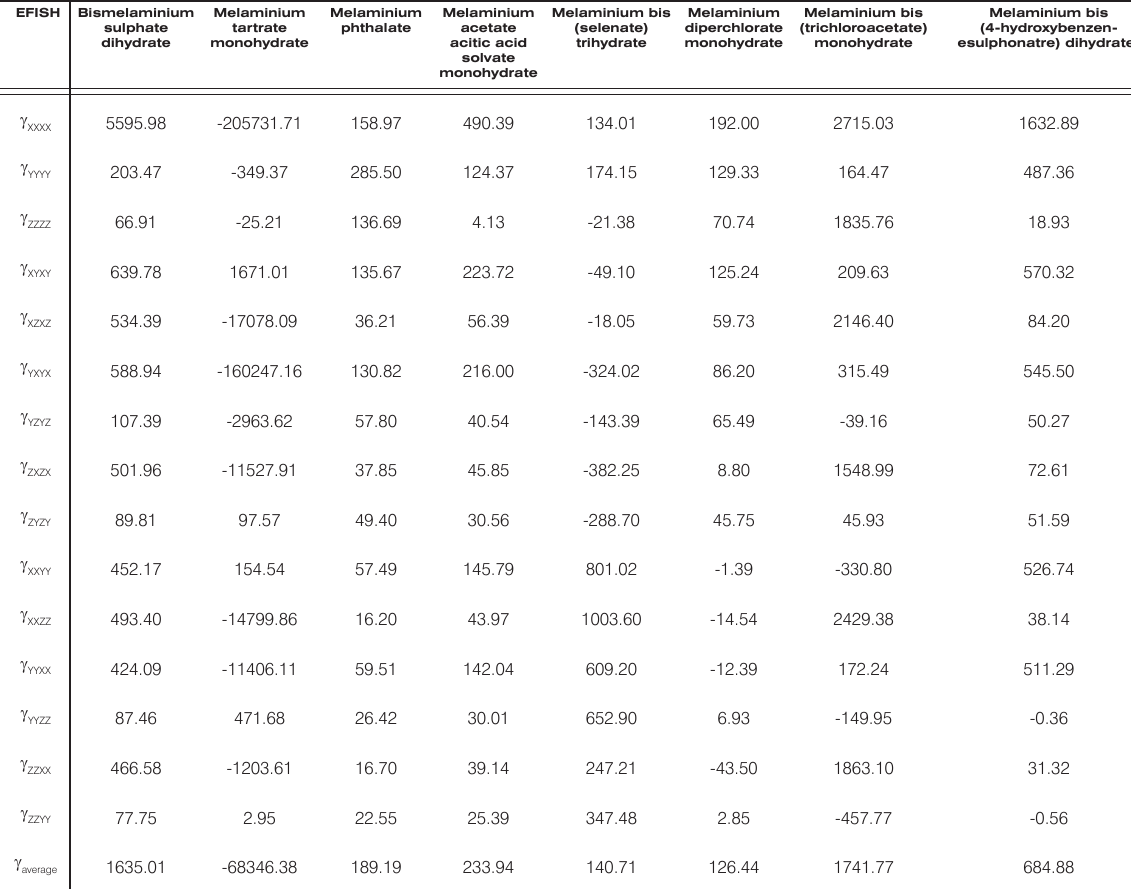
Table 5. Calculated values of g (EFISH) for all investigated molecules (unit of g is 10 -30 esu). EFISH Bismelaminium sulphate